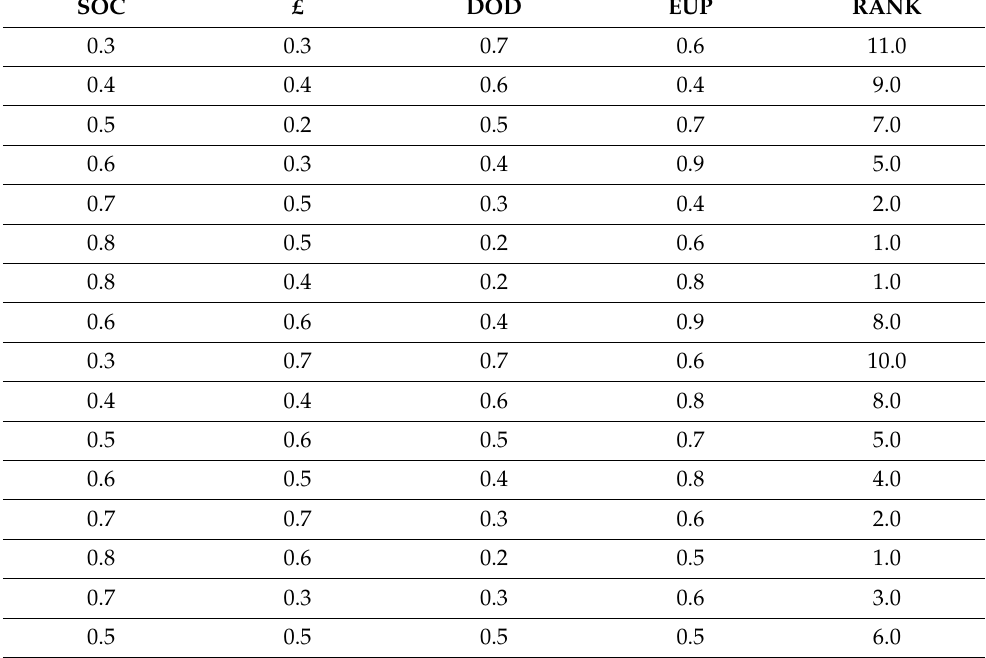
Table 5. Training data for EV